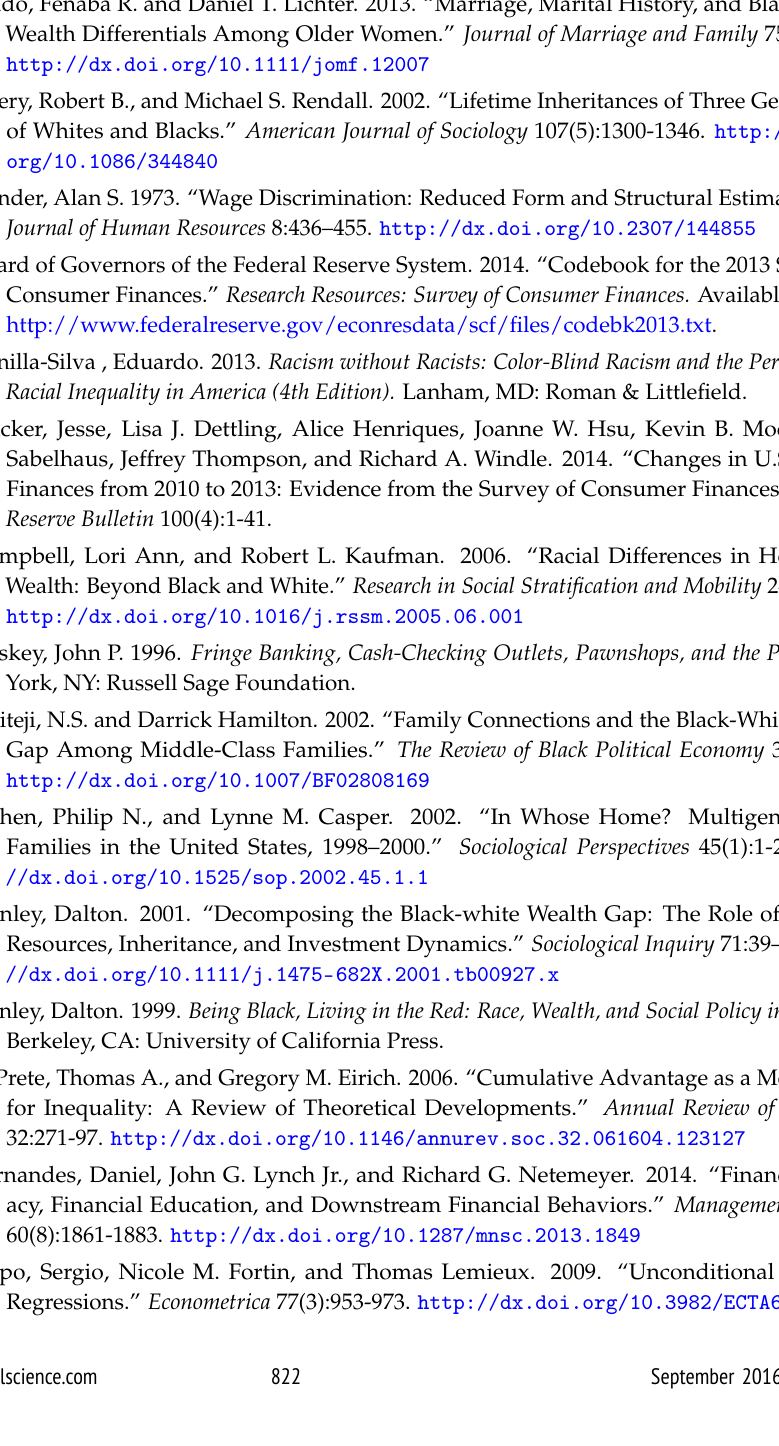
7 Tables 2 and 3 combine predictor variables into the four sets of explanations for wealth inequality. Appendix Tables B and C in the online supplement include results from detailed